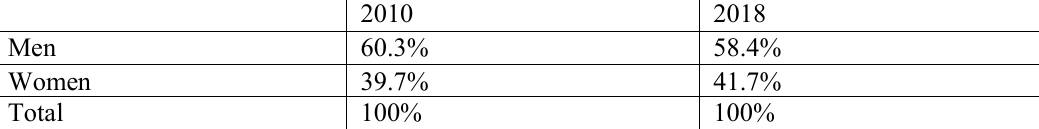
Table 3: Proportion of men and women among the low-literate population